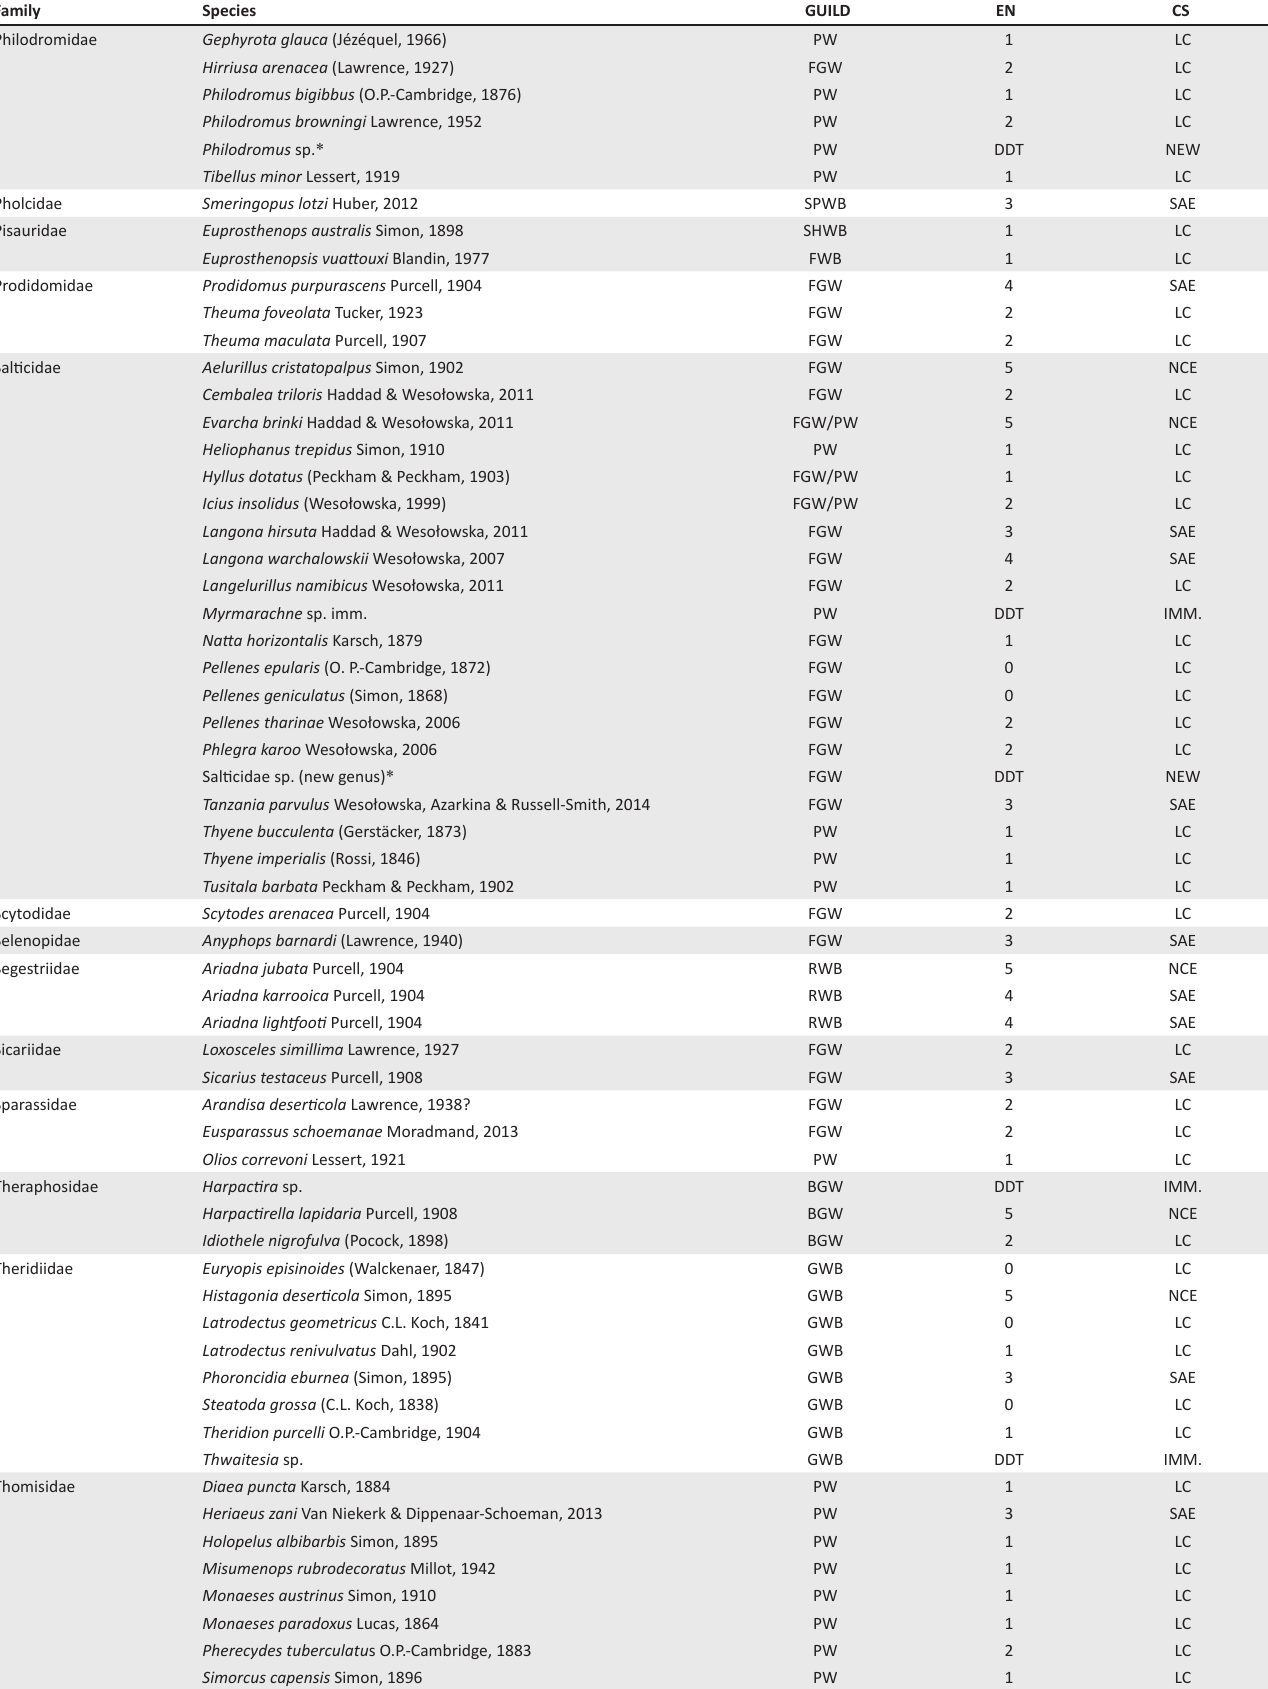
TABLE 1-A1 (Continues...): Checklist of the spiders of Tswalu Kalahari Reserve with guild, endemicity (EN) and conservation status (CS). Family Species GUILD EN